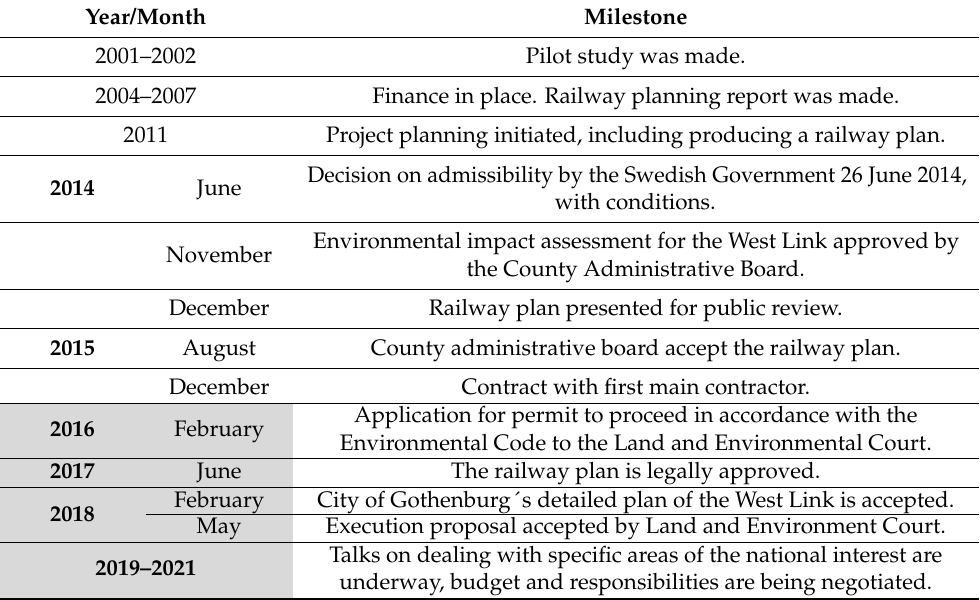
Figure 1. OpenStreetMaps of central Gothenburg in Sweden, including layer of the West Link train tunnel. Source: The West Link Project, STA. Table 1. Milestones in the West Link Infrastructure project. Time of case study marked with grey.